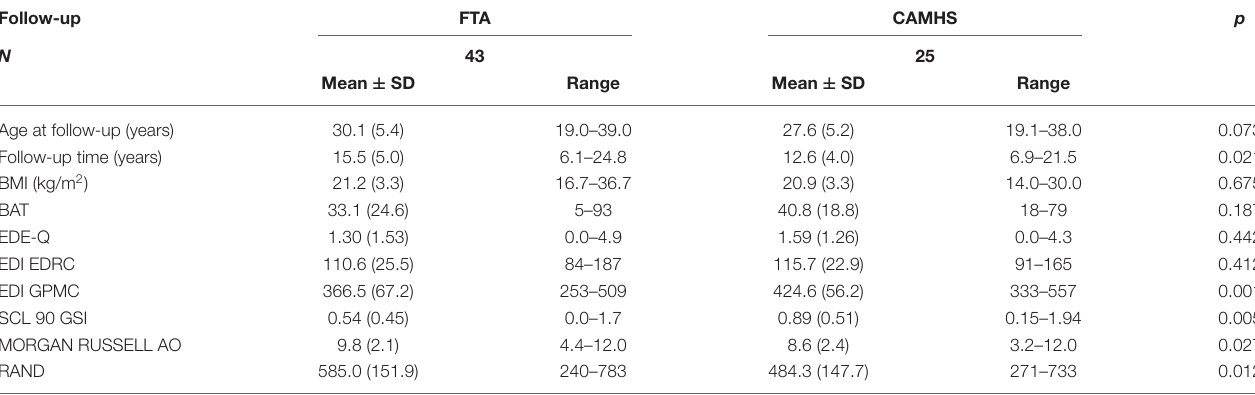
TABLE 2 | Participant characteristics at